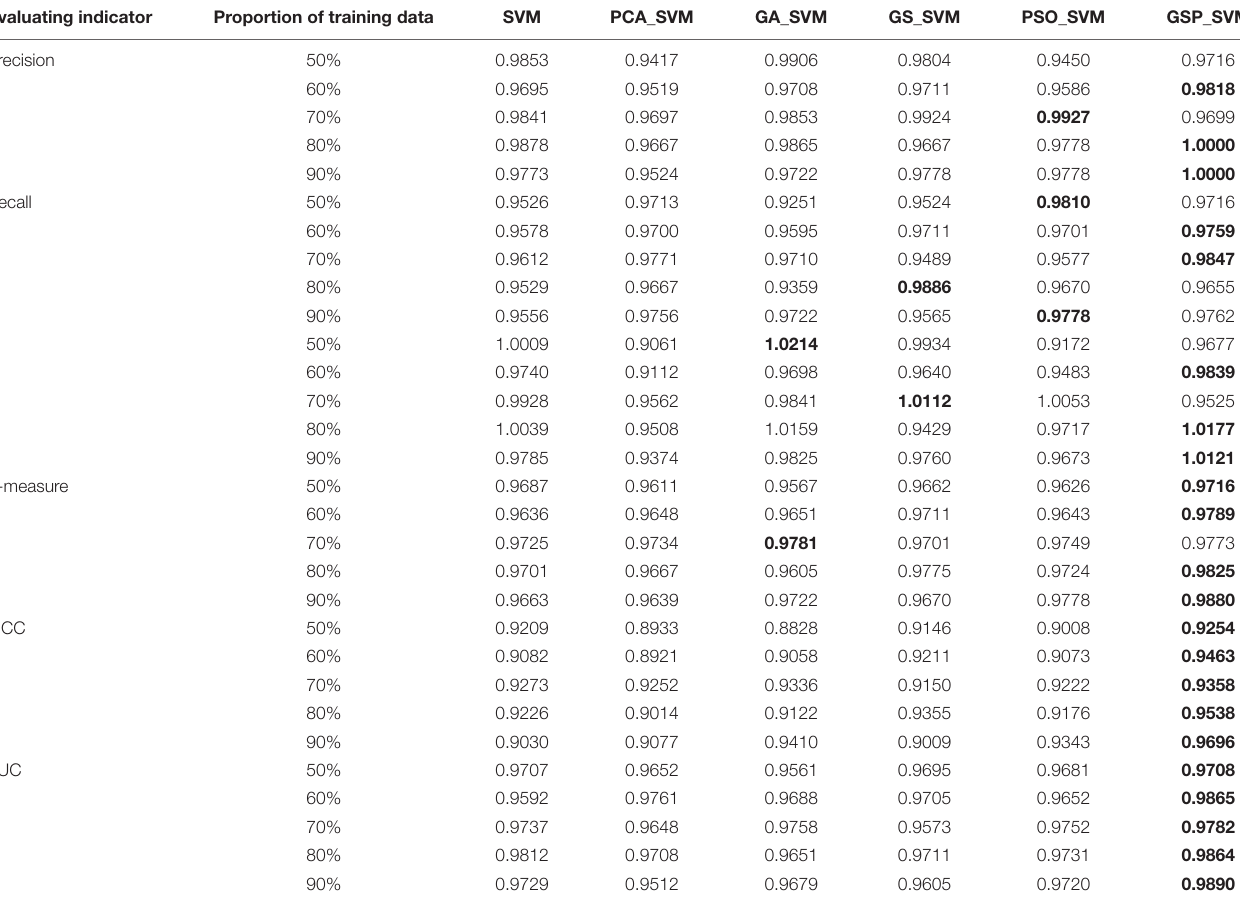
TABLE 2 | Experimental results.